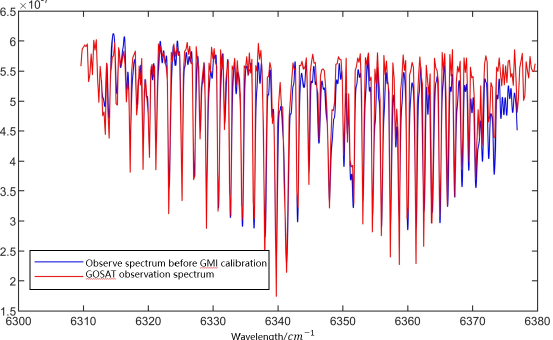
Figure 22. The observed spectrum and the GOSAT spectrum before the GMI calibration.